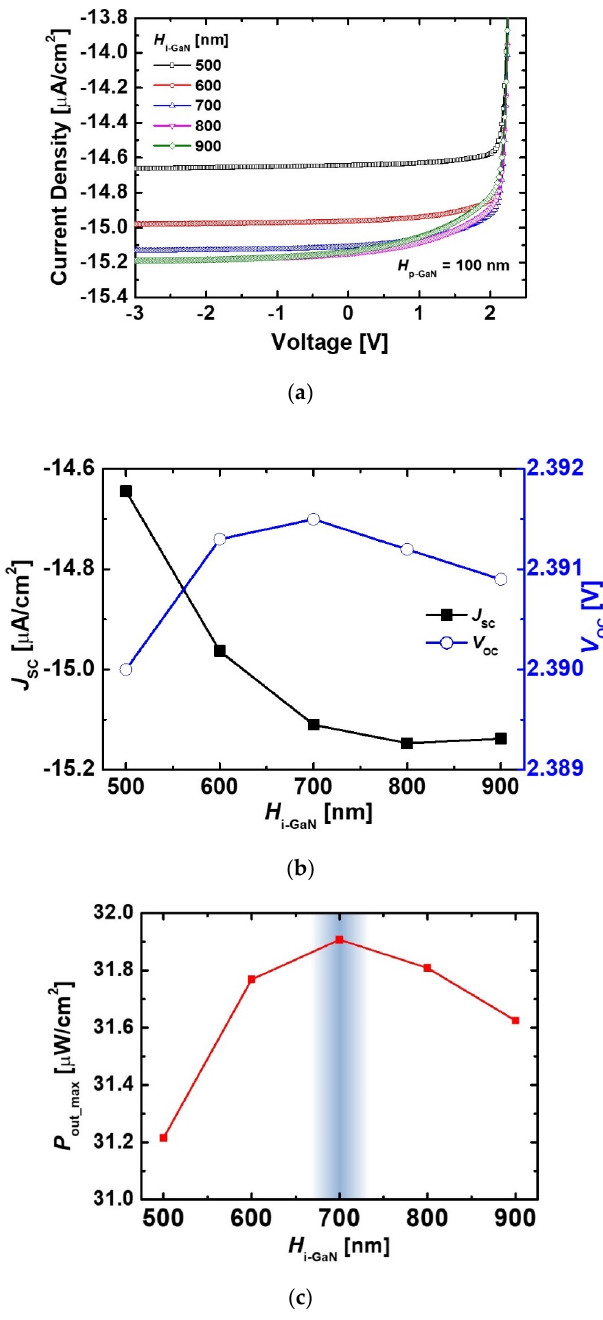
Figure 3. ( a ) Reverse current characteristics of the irradiated diodes with different H i-GaN values. ( b ) Variations of J SC , V OC and ( c ) P out_max as a function of H i-GaN . The H p-GaN was fixed as 100 nm. The D p-GaN , D i-GaN , and D n-GaN were 5 × 10 17 cm −3 , 1 × 10 16 cm −3, and 5 × 10 18 cm −3 , respectively. The variations of J SC , V OC , and P out_max depending on the H i-GaN and H p-GaN are shown in Figure 4. The J SC of the devices increased with a rise in the H i-GaN regardless of the H p-GaN because a high H i-GaN extended the absorption region. When the H i-GaN above 800 nm increased, the J SC slightly decreased due to the recombination phenomenon. As the H p-GaN became shorter, the variation of J SC according to the H i-GaN increased. This result indicated that the absorption rate vs. depth was more a ff ected in the irradiated device with a short H p-GaN . The device with a H p-GaN of 60 nm and H i-GaN of 800 nm was the highest J SC because the J SC was enhanced by an additional absorption near the